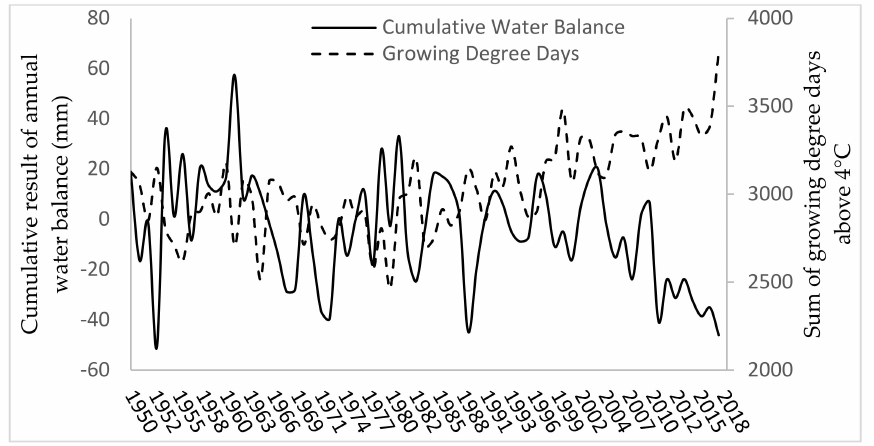
Figure 6. Cumulative temperature in growing degree days above 4 ◦ C and cumulative annual water balance results. The two axes have been setup to enable visual comparison with no regard to their respective